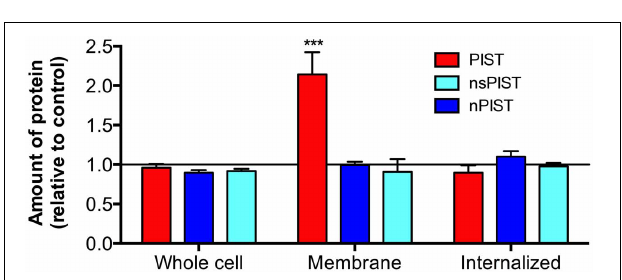
FIGURE 7 | Over-expression of PIST isoforms differently influences cellular fractions of K V 10.1_BBS. Different labeling protocols allowed distinguishing between whole cell, membrane bound and internalized K V 10.1_BBS by ELISA (see Materials and Methods). The fraction of membrane bound K V 10.1_BBS, labeled on living cells, was clearly enriched by expression of PIST but not of the other isoforms ( N = 3; ∗∗∗ p < 0 . 001).